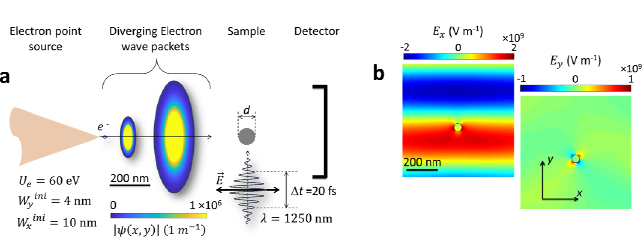
Fig. 1. (a) The topology of the system, constituting of a low-energy electron wave packet interacting with a carbon nanorod which is illuminated by a 20-fs laser pulse at 1250 nm. (b) The carbon nanorod is modeled by the dielectric function of carbon and the scattered field and the electromagnetic potentials are calculated. Shown are the spatial distributions of the total x - and y - components of the electric field, at a given